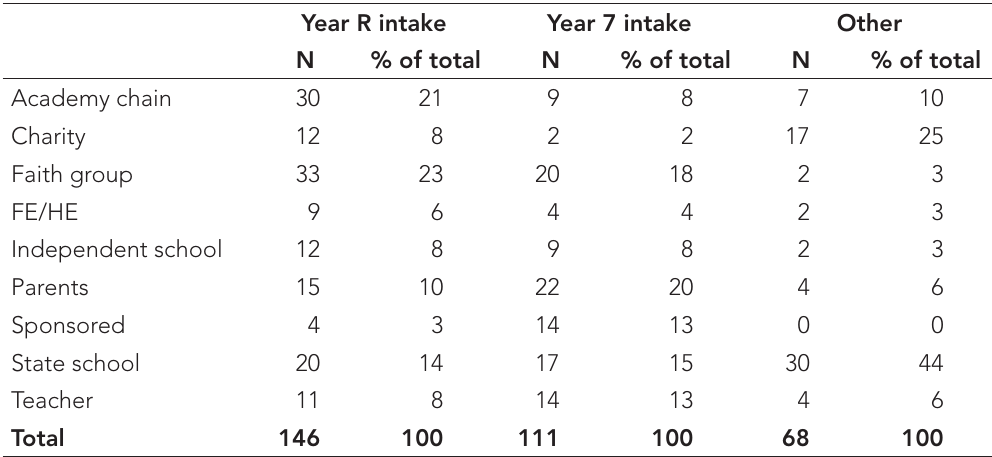
Table 1: Number of free schools by provider category (Waves 1 to